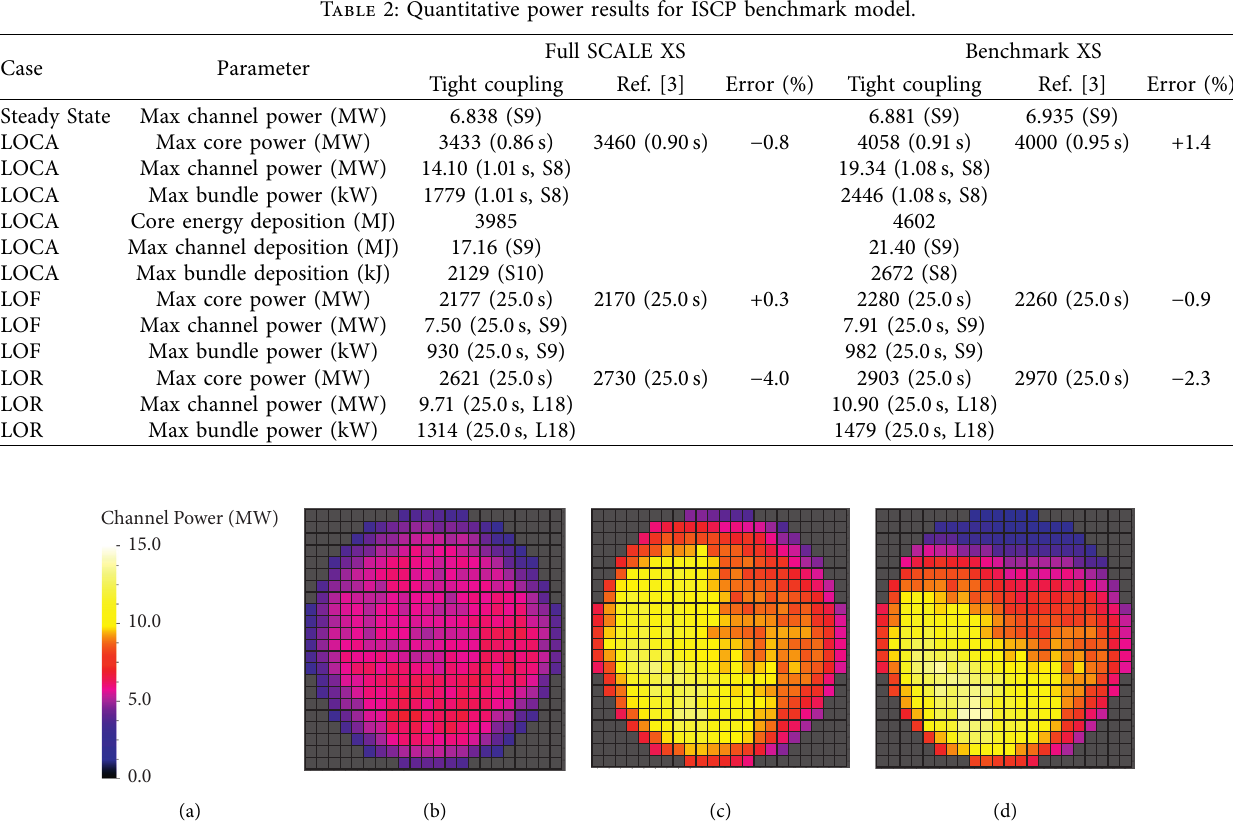
Figure 13: Inlet header breaks channel power profile. Color legend provided by (a). Profiles given are as follows: (b) before the transient, (c) at peak core power, and (d) at peak channel